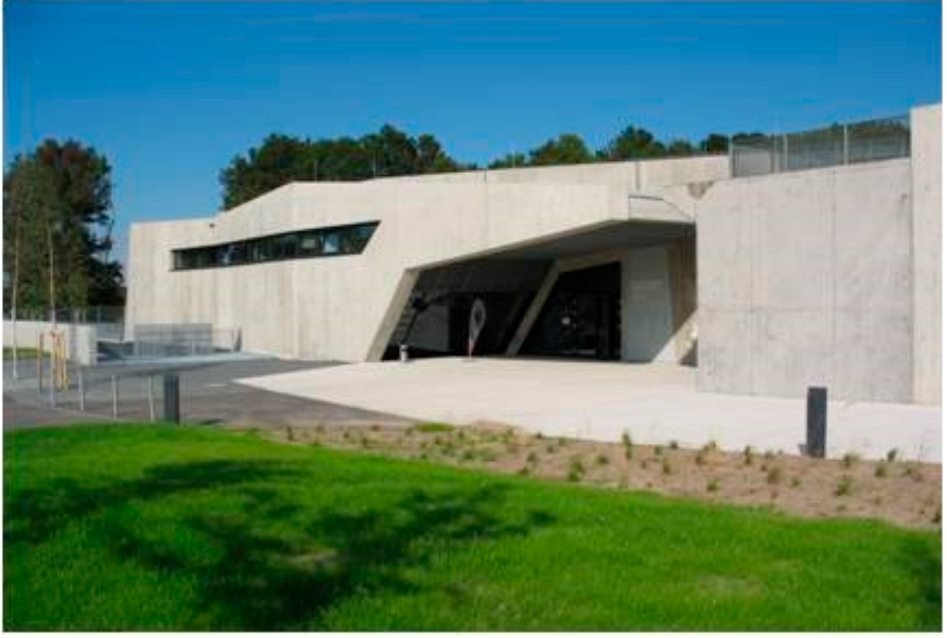
Figure 18. Visitor Center entrance at Messel Pit WHS.